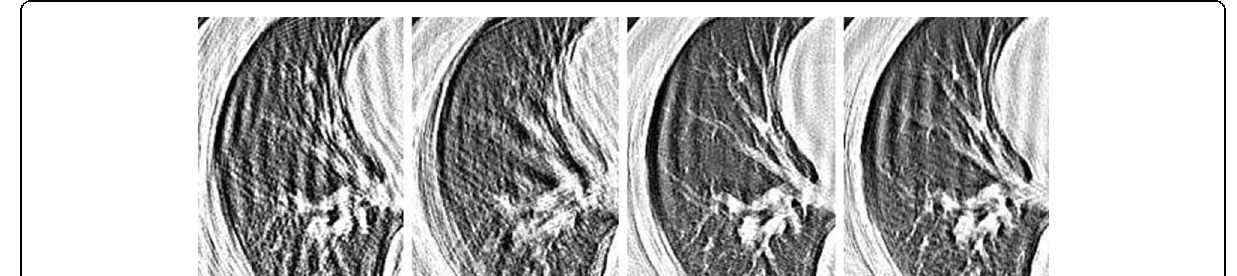
Fig. 5 Comparison of reconstructed images of local details amplification with different reconstruction methods (SNR = 20 dB)